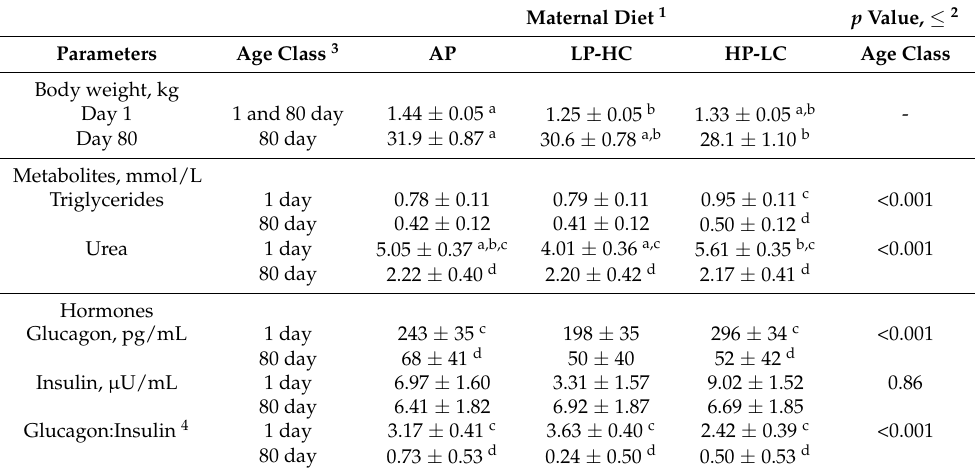
Table 1. Body weight, plasma and serum biochemical parameters of 1 and 80 day old porcine offspring exposed to low (LP-HC; 1:10.4), high (HP-LC; 1:1.3), or adequate (AP; 1:5) protein to carbohydrate ratio diets during